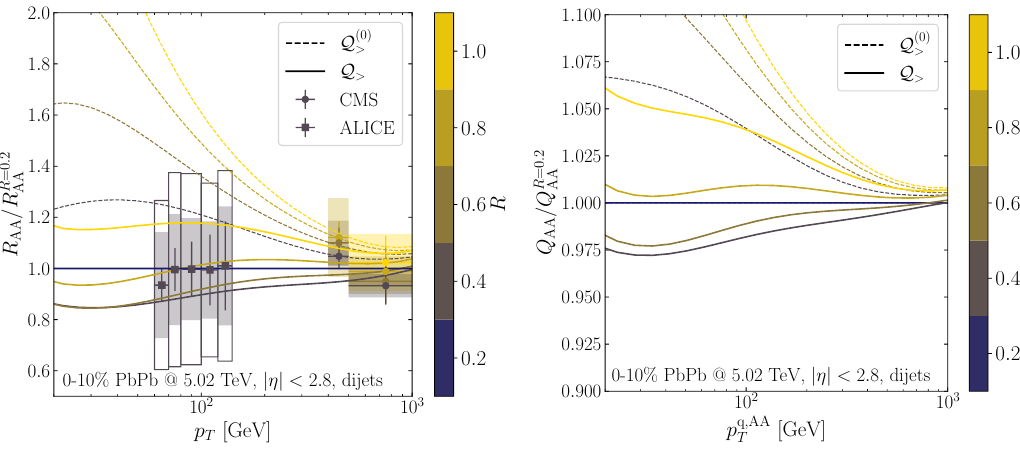
Figure 6 . Same plots as in figure 5, but taking the ratio of different cone sizes to enhance the differences between single and multi-parton quenching. On the x -axis of the right panel we used instead of p q , pp from p q , AA T T